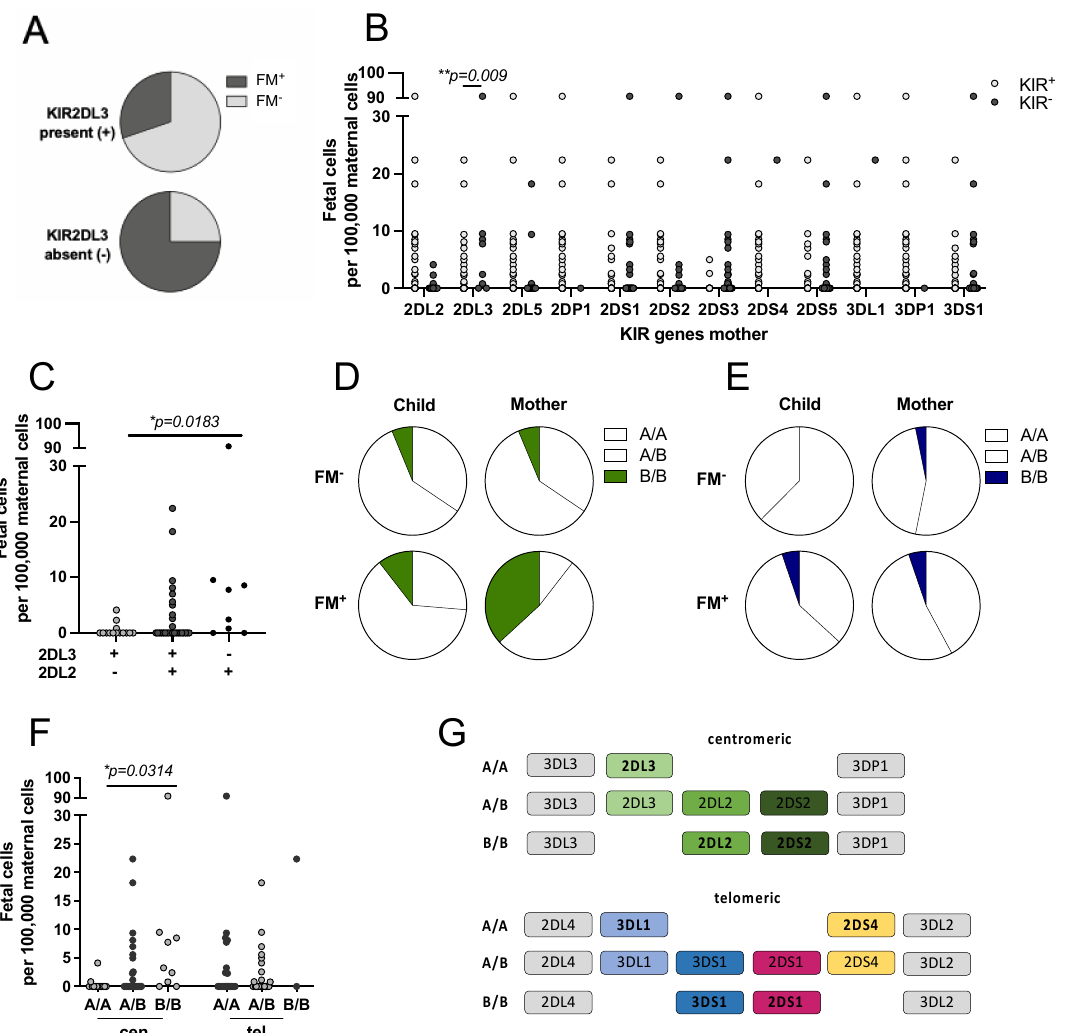
Figure 3. Influence of KIR genes on the occurrence and level of FM. ( A ) Frequency of KIR2DL3 gene presence or absence in FM − and FM + mothers. ( B ) Mothers were KIR genotyped and grouped depending on presence or absence of KIR genes. Level of FM was compared in KIR positive and KIR negative groups. ( C ) Mothers were grouped depending on their KIR2DL2 and KIR2DL3 combinations and the level of FM was compared between the groups. ( D , E ) Child and mother were grouped depending on their centromeric and telomeric KIR genes and the presence or absence of FM. ( D ) Centromeric motif and ( E ) telomeric motif frequencies classified as depicted in ( G ). ( F ) Influence of maternal centromeric and telomeric KIR gene regions on the amount of microchimeric cells. ( G ) Illustration of the centromeric and telomeric KIR gene regions. Exact n values are provided in Supplementary Table S2. Statistical analysis of frequencies was performed using Fisher’s exact test for two groups or Chi 2 for more than two. Mann–Whitney test was used for comparison of two groups; Kruskal–Wallis test followed by Dunn´s multiple comparison test was used for more than two groups. Statistical significance * p < 0.05; ** p < 0.01.